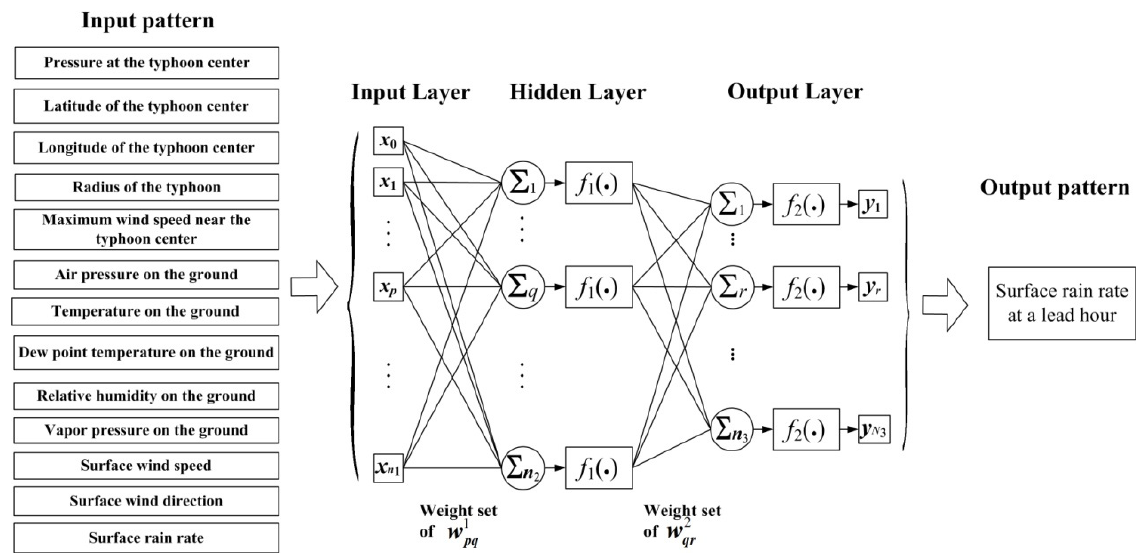
Figure 1. Architecture of the three-layer multilayer perceptron (MLP) neural